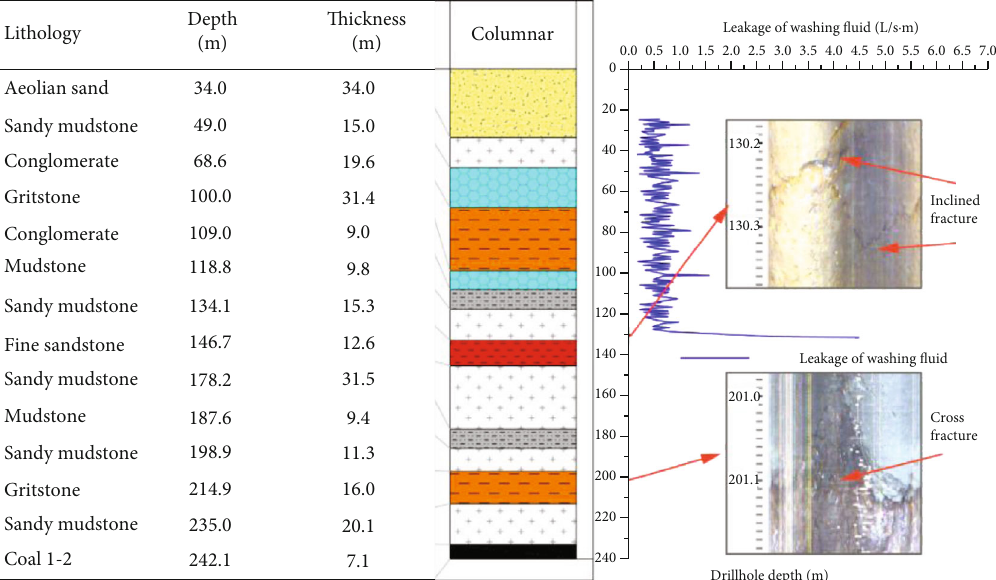
Figure 4: The histogram of the BLT-1 drillhole and the measurement results of